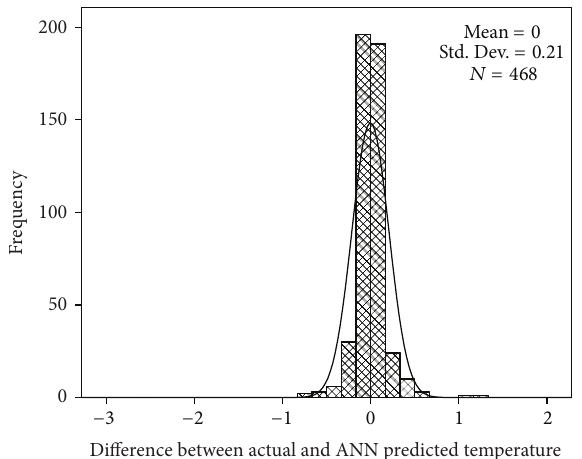
Figure 7: Distribution of the difference between predicted temper- ature by ANN and actual values in the test